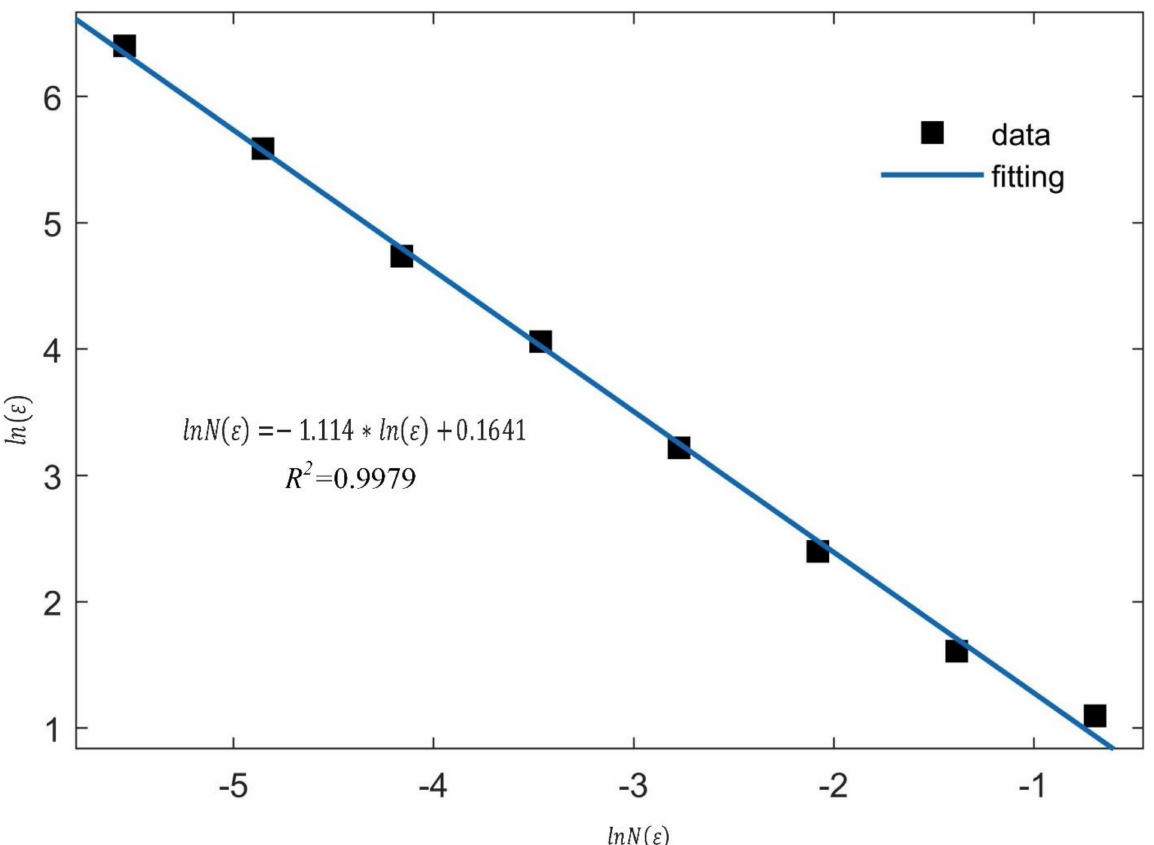
Figure 2. Linear fitting of concrete crack box fractal